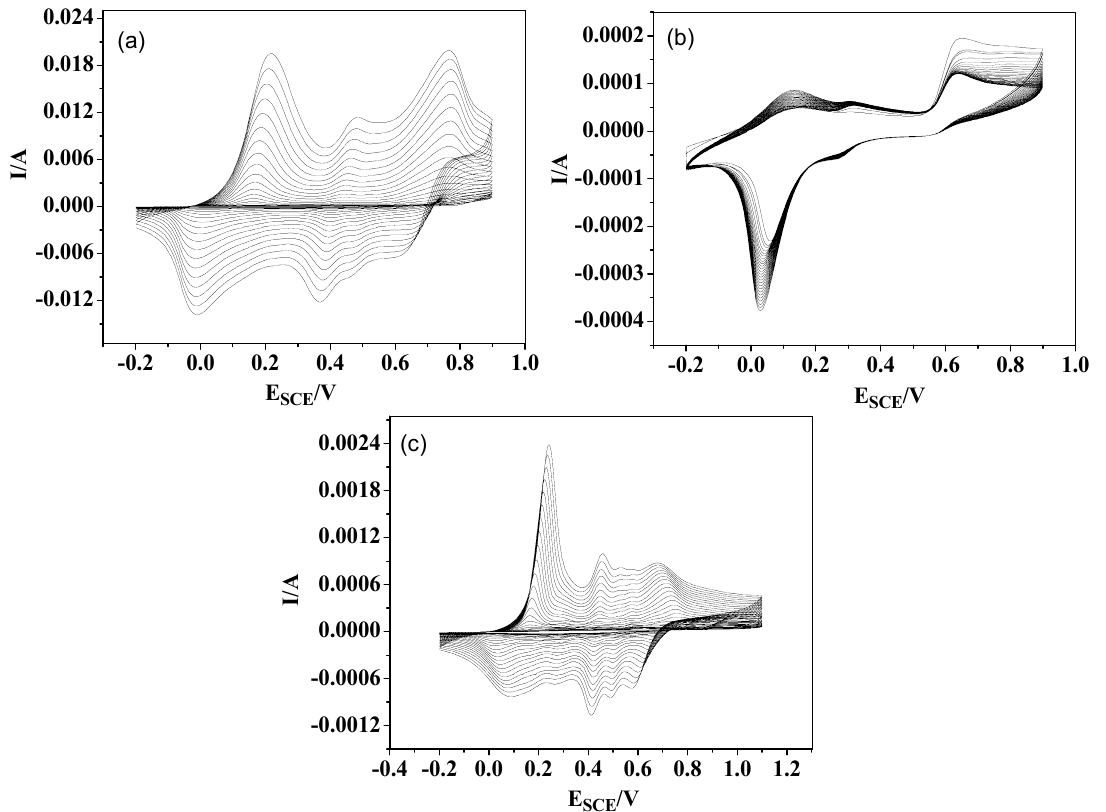
Figure 10. CV results recorded during the growth of ( a ) PANI, ( b ) PHA, and ( c ) PACHA film.